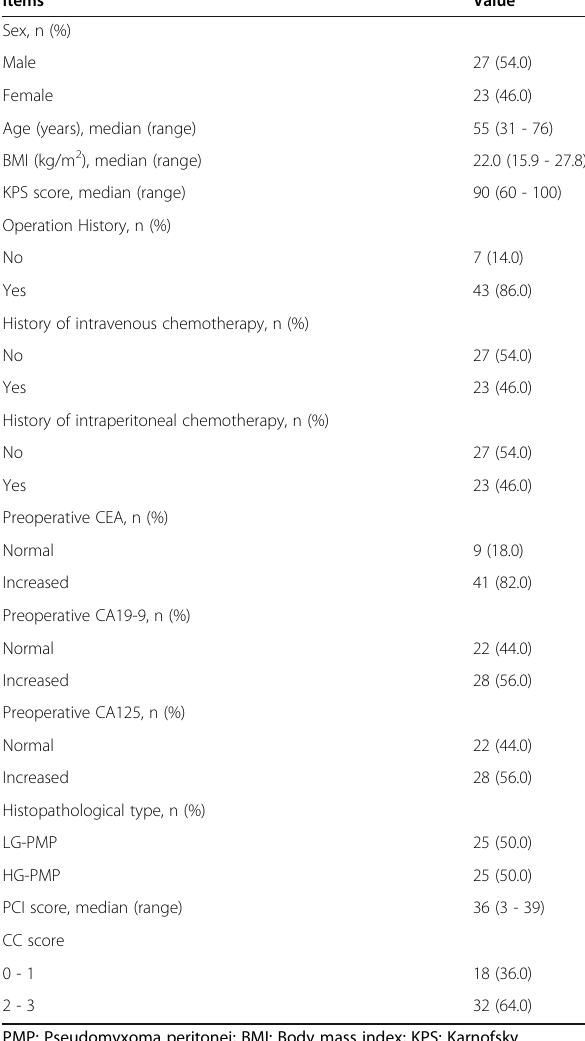
Table 1 Major clinicopathological features of 50 PMP